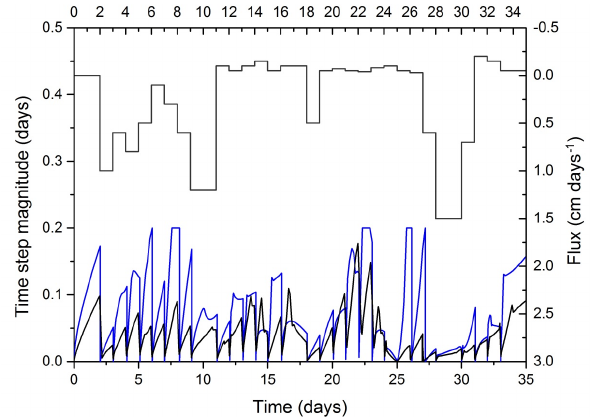
Figure 9. Time-step magnitudes during the simulation for TC3 for the time-stepping strategy based on truncation error (TA_S in blue, TA_T in black, time-varying boundary conditions at the